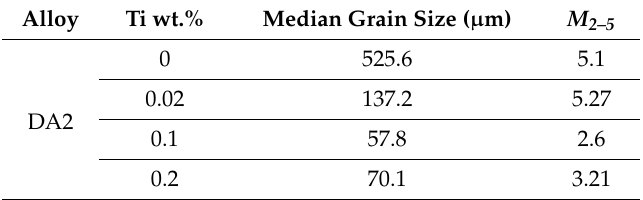
Table 6. Maximum and optimum Ti wt.% addition for hot-tearing resistance. Alloy